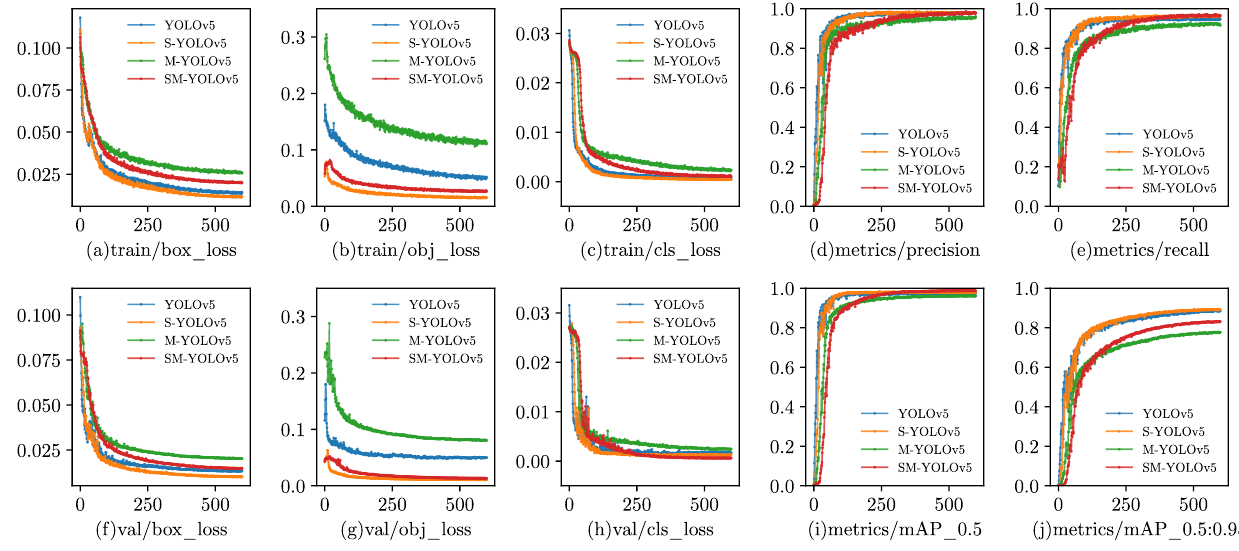
Figure 7. Training results of different